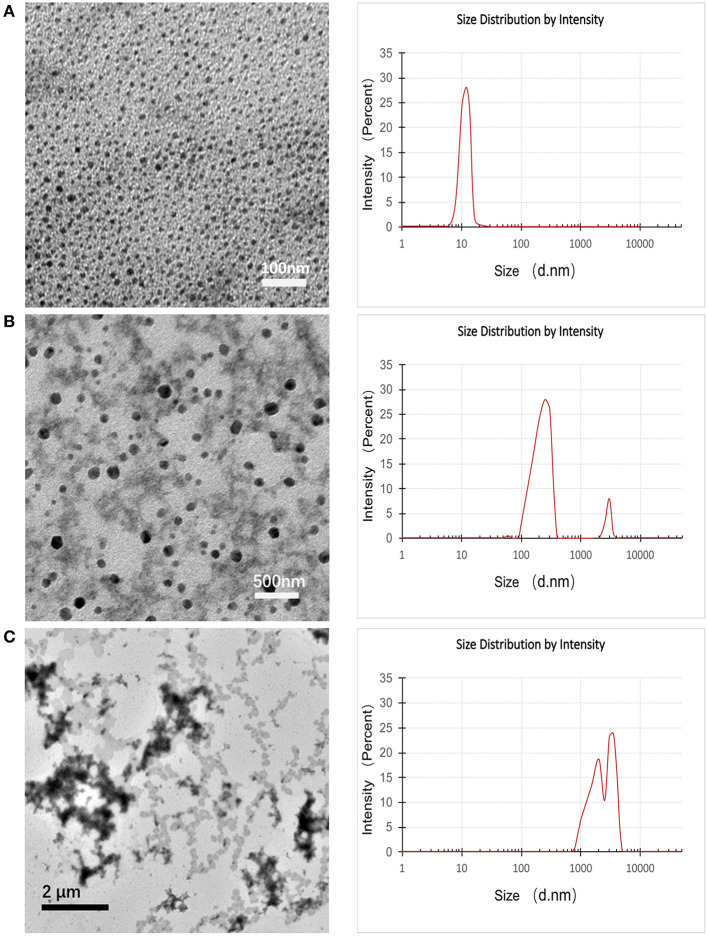
TEM images (left) and DLS images (right) of pH-MNPs in pH 6 buffer at different elapsed times of (A) 0, (B) 10, and (C) 120 min.